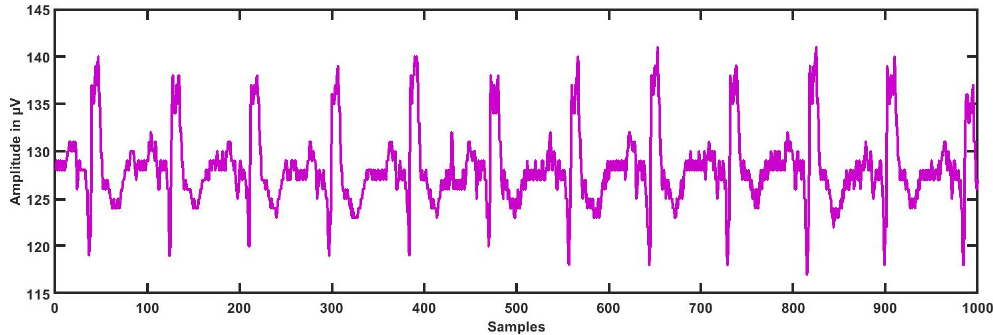
Figure 4. Typical high-risk hypertension (HRHT) stroke ECG signal.